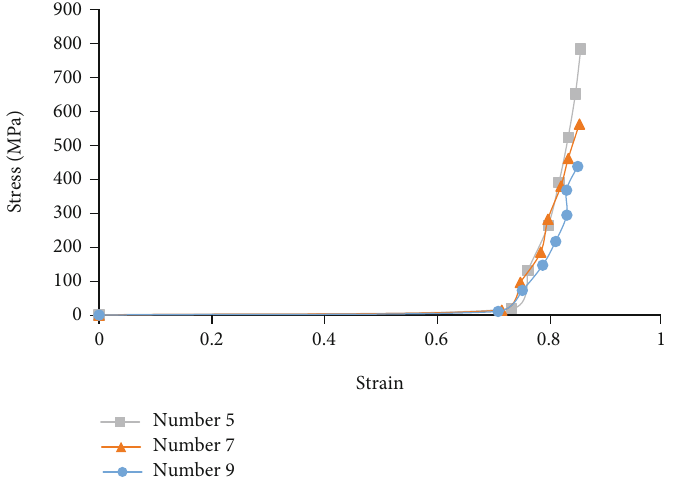
Figure 8: Stress-strain curve of proppant column height (initial proppant column height: 10